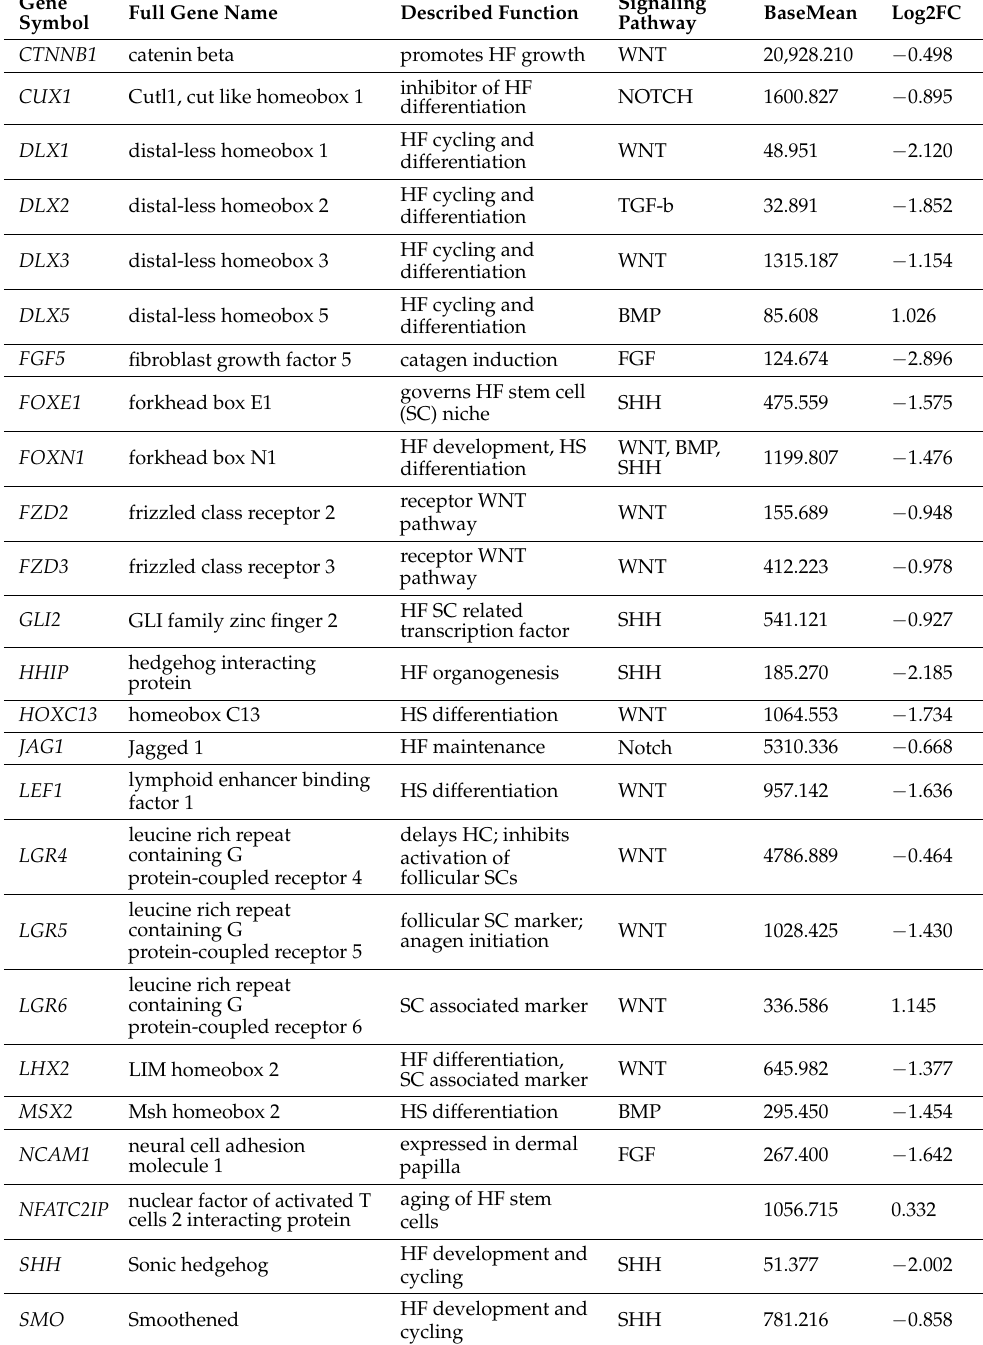
Table 7. Differentially expressed genes associated with a role in hair follicle (HF) morphogenesis and the hair cycle (HC) identified by transcriptome analysis comparing unaffected skin of control dogs and dogs affected with aRFA (n = 11) with alopecic skin of dogs with aRFA (n =